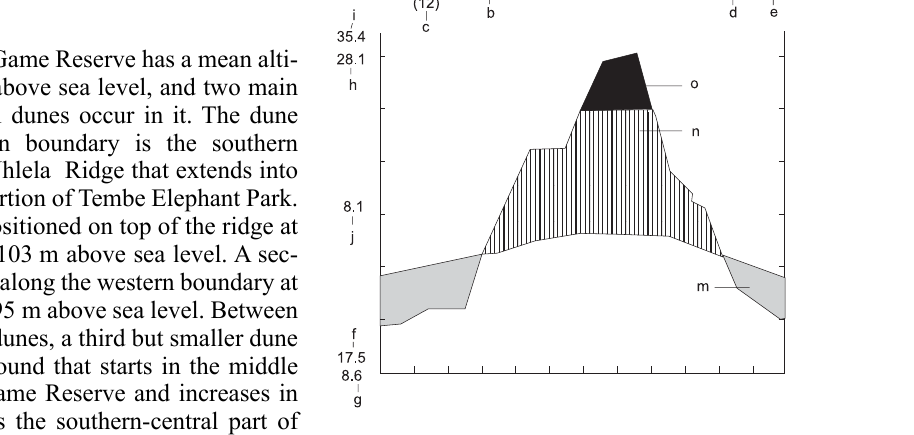
Fig. 3. Climatogram of the Sihangwane Weather Sta- tion, Tembe Elephant Park, Maputaland, northern KwaZulu-Natal, South Africa (b = height above sea level, c = duration of observations in years, d = mean annual temperature in °C, e = mean annual precipita- tion in mm, f = mean daily minimum of the coldest month in °C, g = lowest temperature recorded in °C, h = mean daily maximum of warmest month in °C, i = highest temperature recorded in °C, j = mean daily temperature variation in °C, m = dry season, n = humid season, o = mean monthly rainfall > 100 mm) following Walter (Cox & Moore